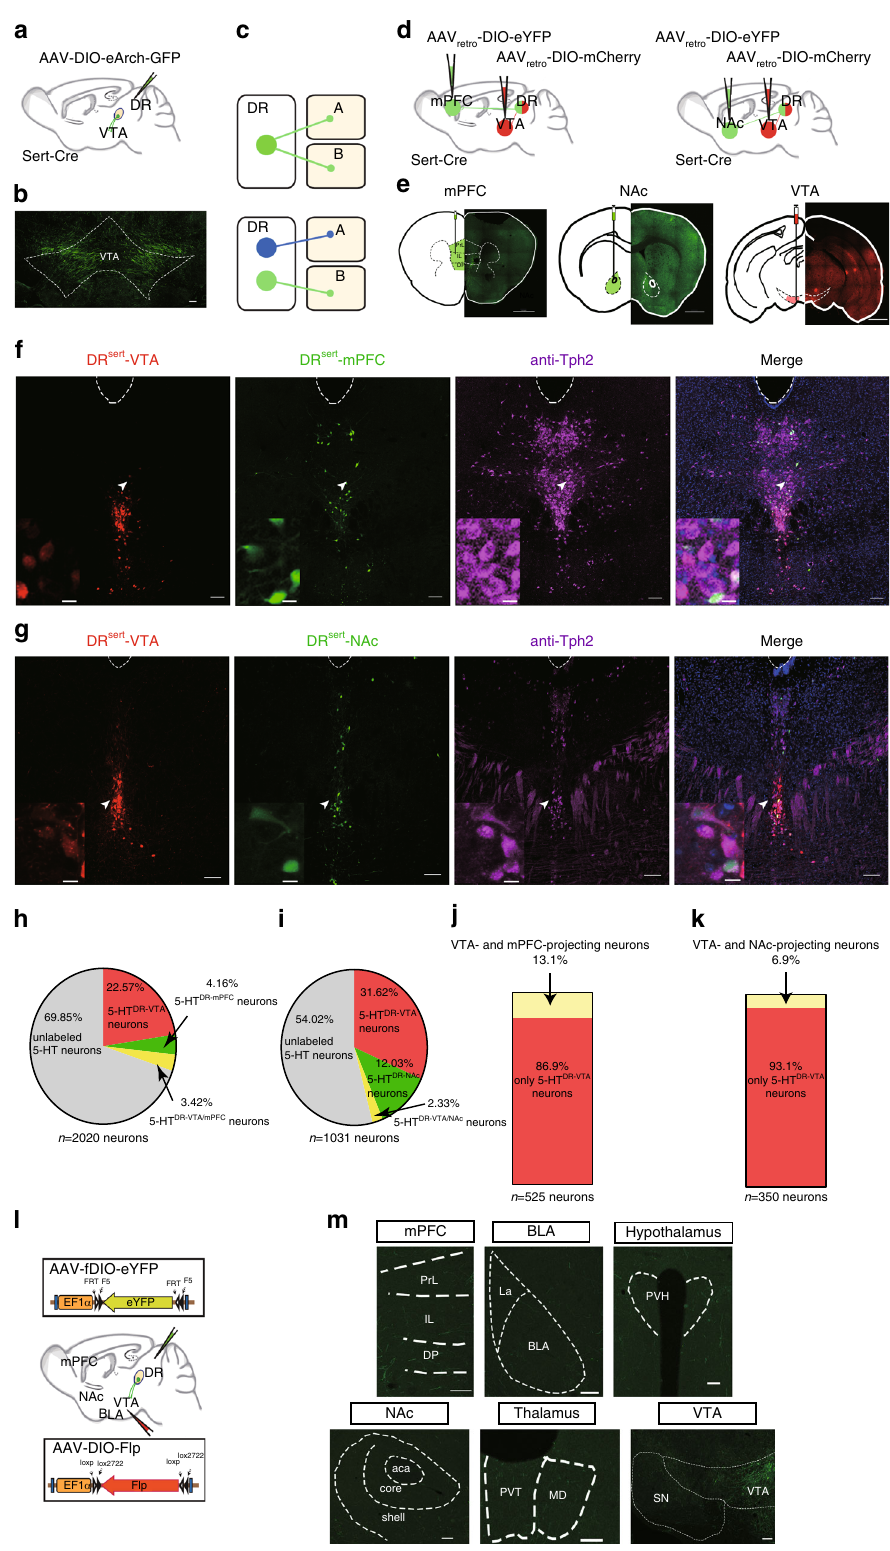
Stimulation of SERT fi bers evokes glutamate and 5-HT effects . Approximately two-thirds of the serotonergic neurons in the DR co-express vesicular glutamate transporter 3 (VGluT3) 33 , a vesi- cular transporter that is believed to concentrate glutamate into synaptic vesicles 34 , and co-release glutamate 26,35 . To determine the neurotransmitter identity of 5-HT DR → VTA neurons, we